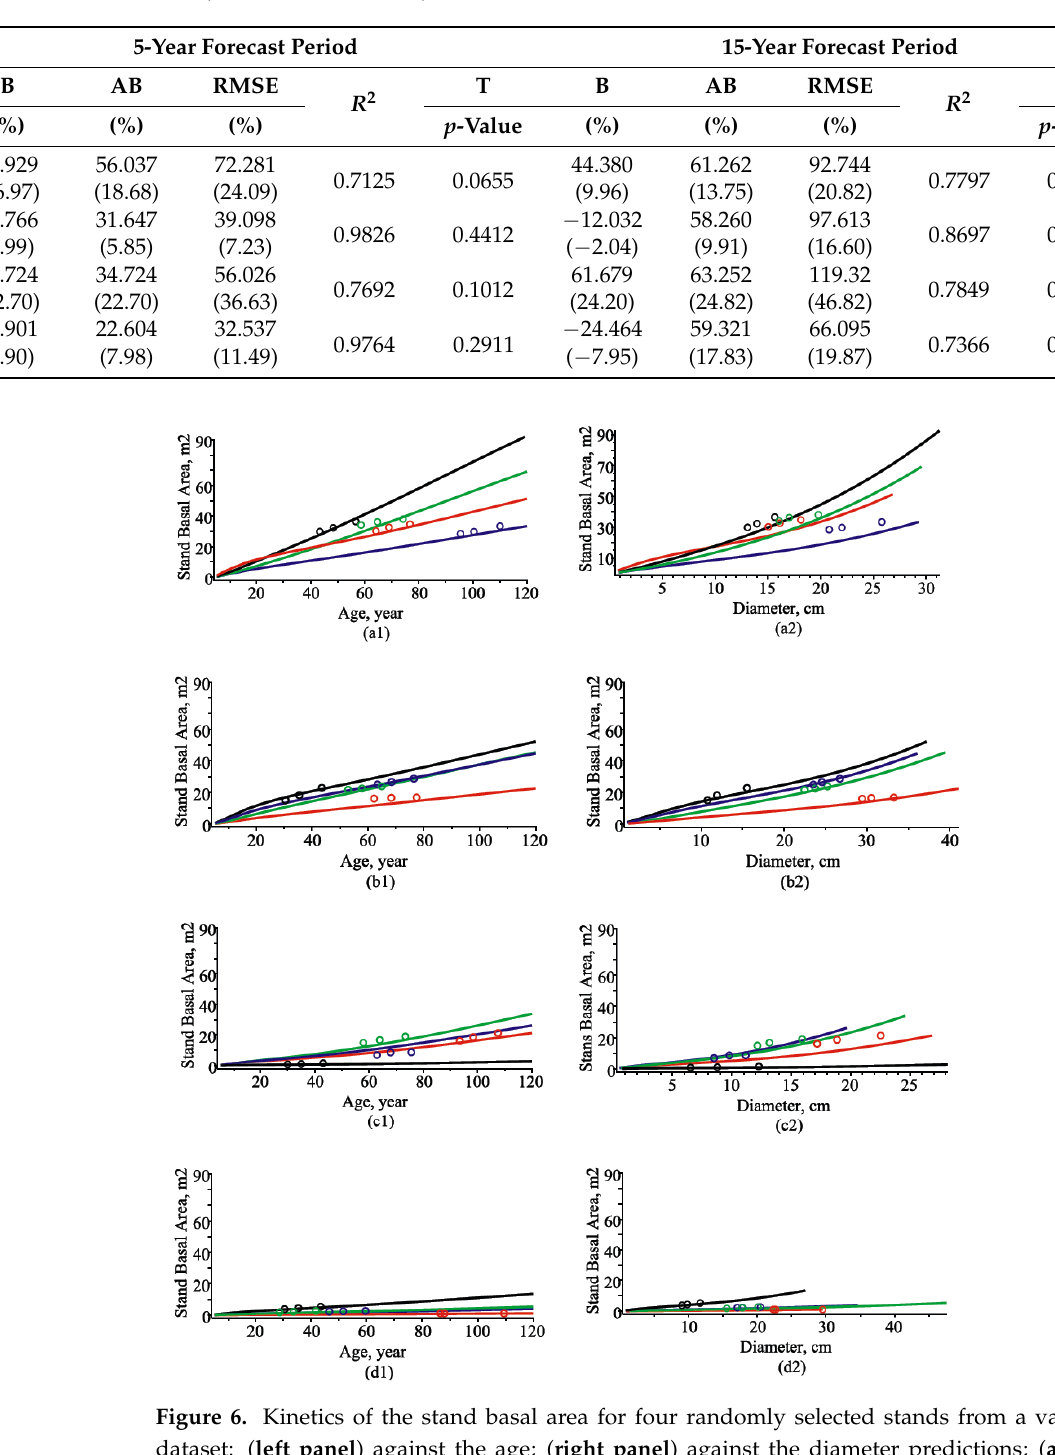
Table 10. Statistical measures and p -values of the Student’s t -test for the forecasts of the tree basal area (whole-stand scenario).